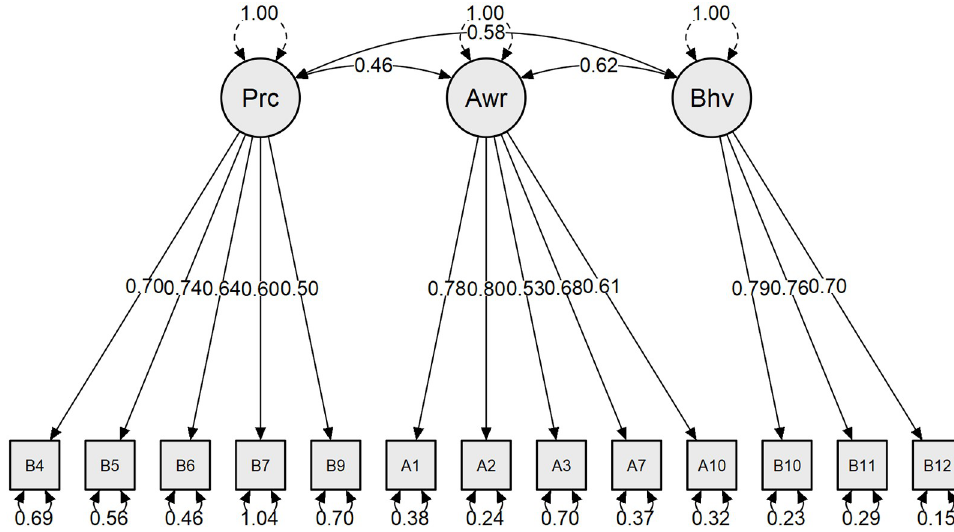
Fig 2. CFA results of awareness, practice and behavior construct (Prc: Practice; Awr: Awareness; Bhv: Behavior). https://doi.org/10.1371/journal.pone.0279259.g002 Table 6. The reliability results for awareness, practice and behavior construct (n: 308). Reliability Analysis